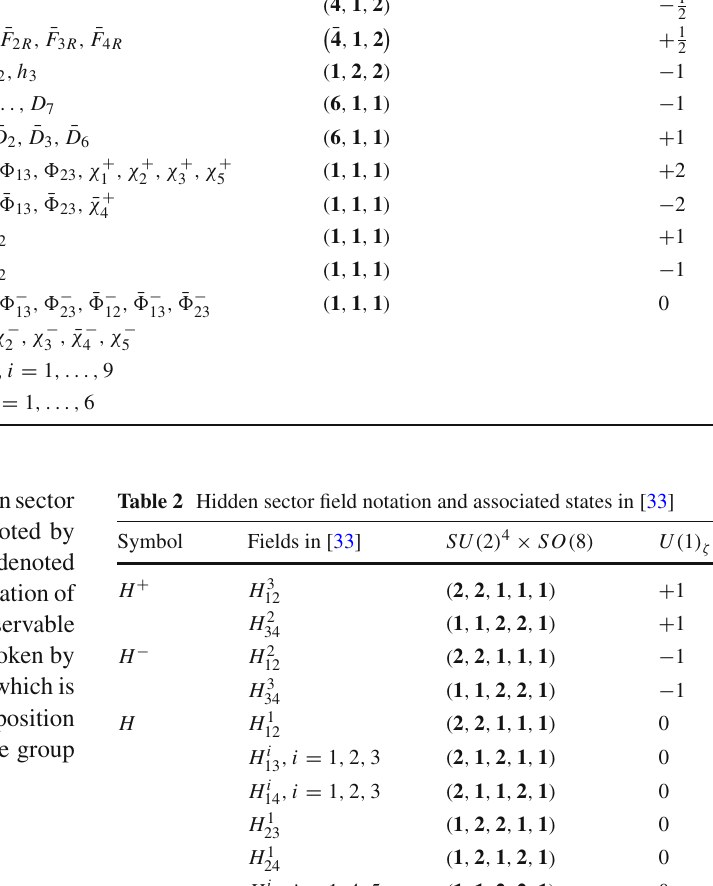
Table 1 Observable sector field notation and associated states in [33]